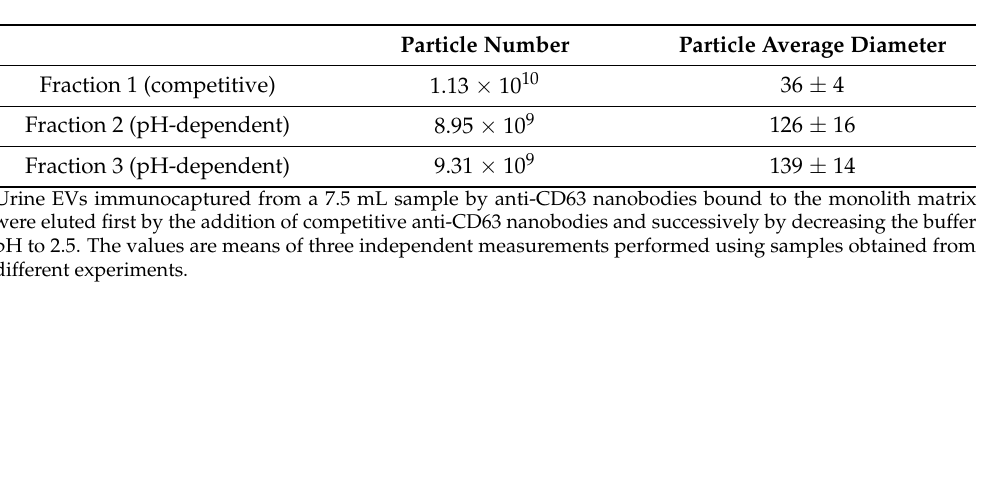
Table 2. Characteristics of the EVs eluted from the monolith